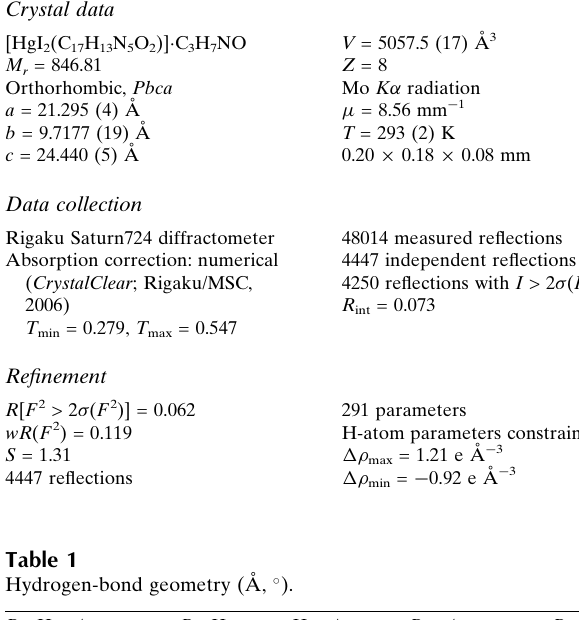
Hydrogen-bond geometry (A˚ , (cid:4)